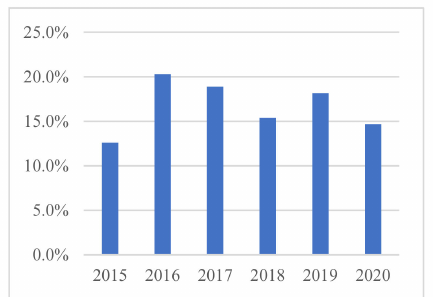
Figure 2. Breakdown of dataset by year of publications.